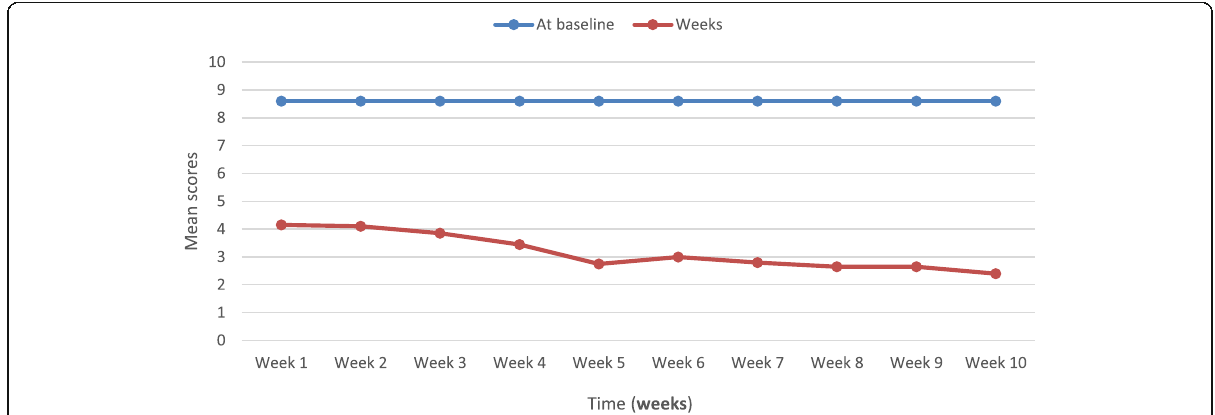
Fig. 3 Line graph showing the mean comparison of pain levels (post visual analogue scale scores) in males across 10 weeks compared with the baseline (after the intervention). The graph maintains a steady slope from the 1st week to the 5th week. It spikes at the 6th and 7th weeks then slopes to plateau at the 8th to 10th